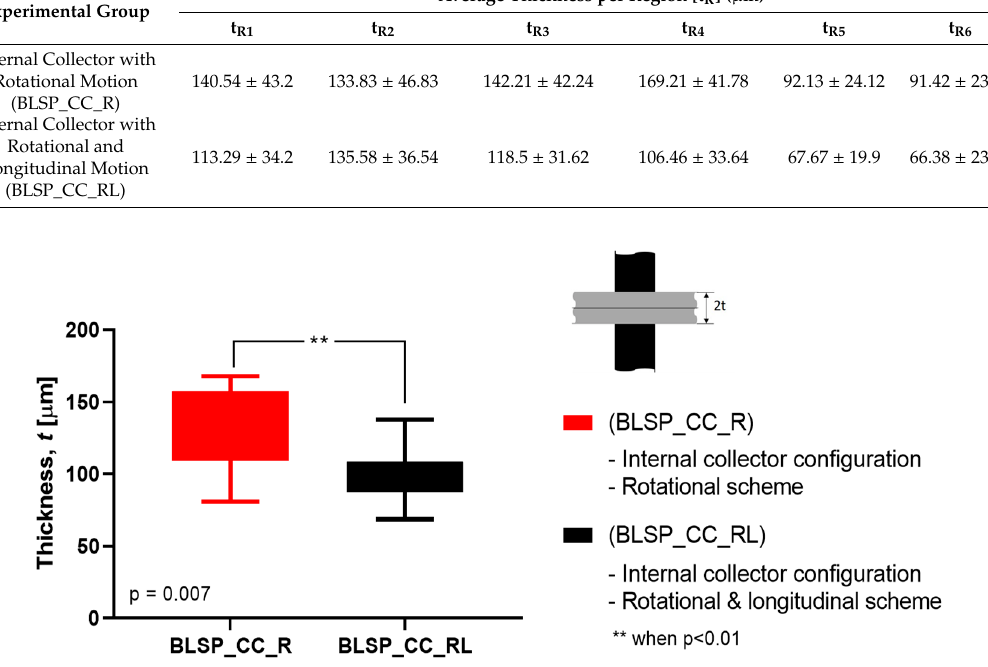
Figure 17. Average membrane thickness of the whole vascular graft considering all regions. (A Student’s t-test was performed to determine any statistically significant differences between experiments. All tests were carried out at a 95% confidence interval).